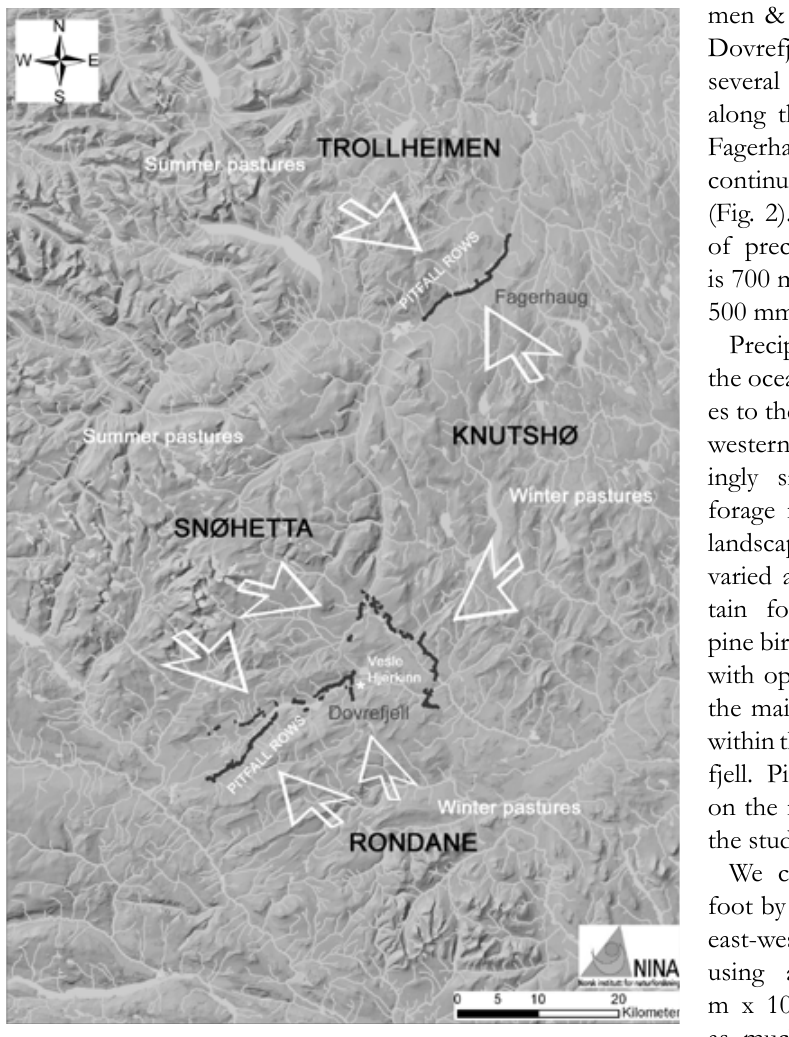
Fig. 2. The trapping systems at Fagerhaug and Dovrefjell, and appar- ent former reindeer migration routes between summer - and winter